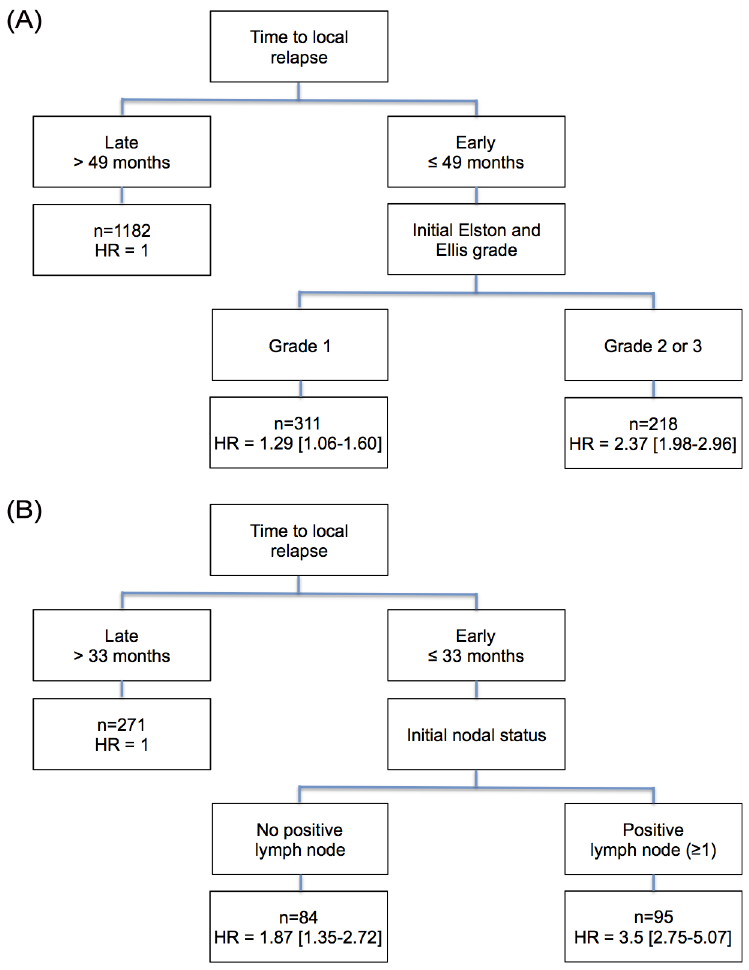
Fig 3. Decision tree algorithm HR = hazard ratio for distant disease at 10 years. (A) Patients with hormone receptor positive tumors. (B) Patients with hormone receptor negative tumors.